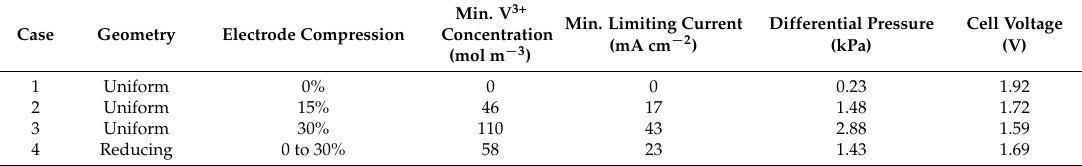
Table 1. Key values for Cases 1 to 4. Results for simulations of 40 cm 2 cells in a 5 (width) × 8 (length) cm configuration charged at 160 mA cm − 2 with electrolyte at 90% state of charge (SOC) and a flowrate of 10